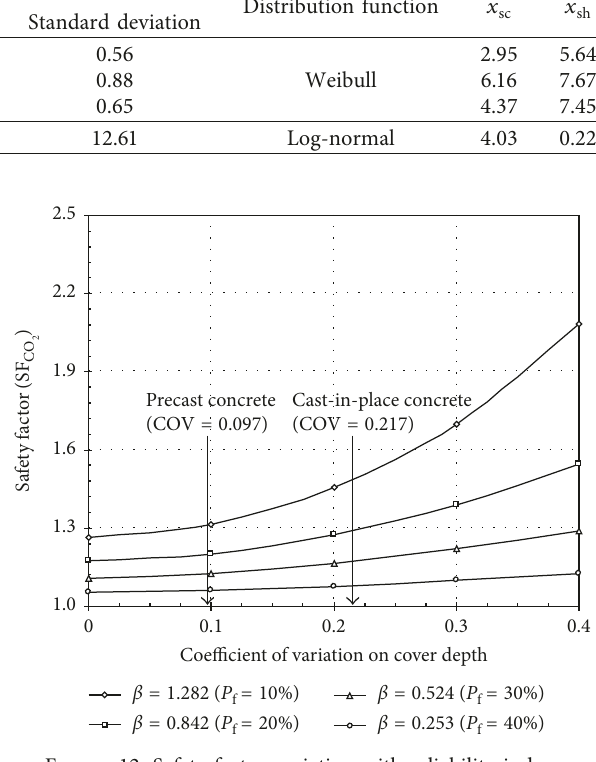
Figure 12: Safety factor variation with reliability